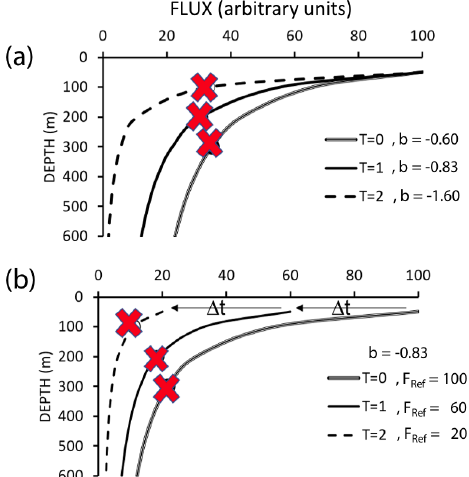
Figure 19. Scenarios which could lead to flux not systematically decreasing with depth. (a) Depicts constant flux at the reference depth, with time variant values of the Martin b parameter. (b) De- picts a scenario with constant Martin b , but decreasing flux at the reference depth over time (after Giering et al., 2017). Red marks indicate sampling points in both figures, illustrating how temporal delay could lead to observations of increasing flux with